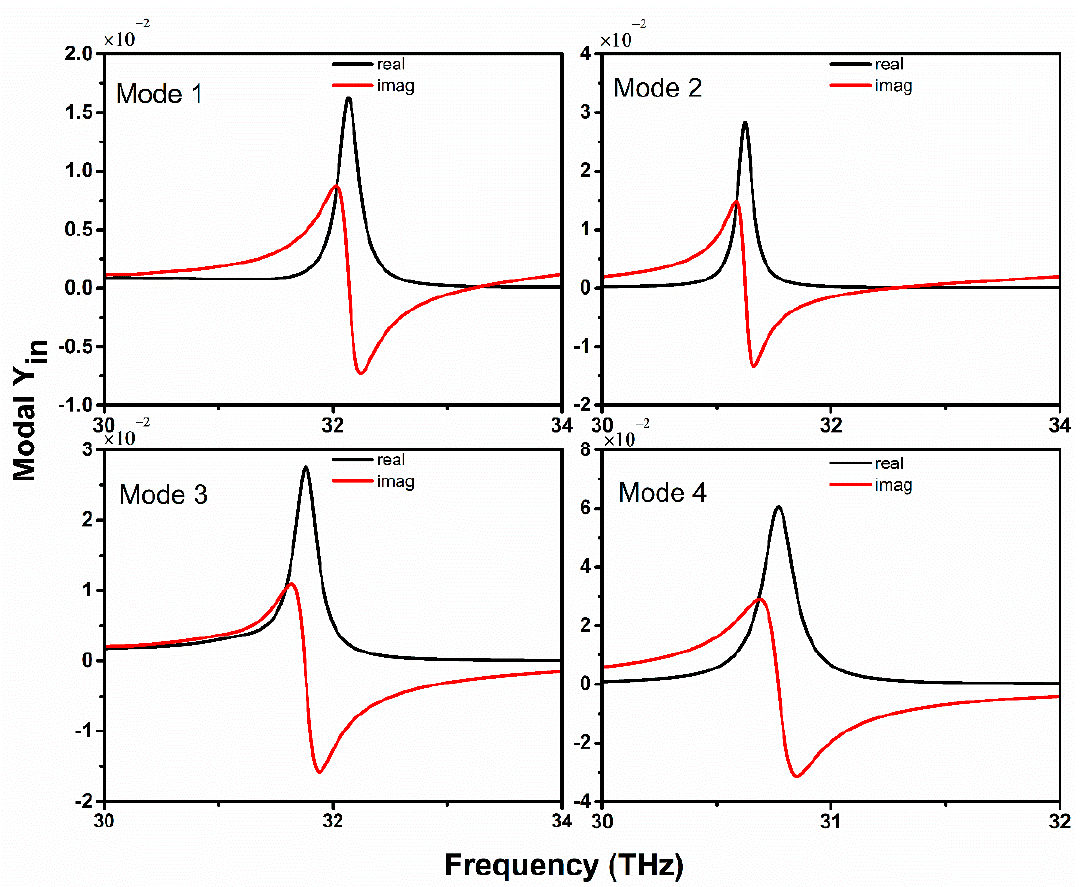
Figure 12. The real and imaginary input admittance at four di ff erent characteristic modes.